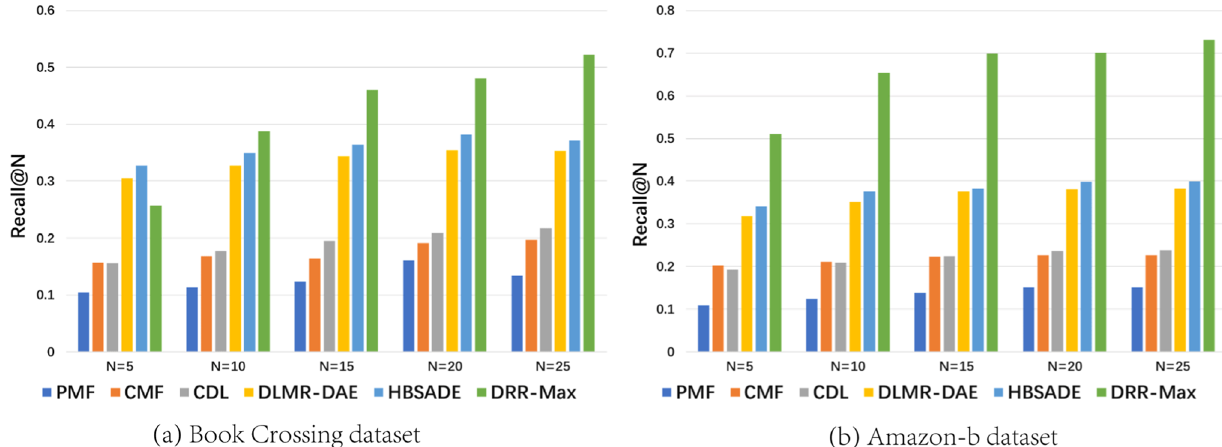
Fig. 5 Recall for Book-crossing and Amazon-b data sets